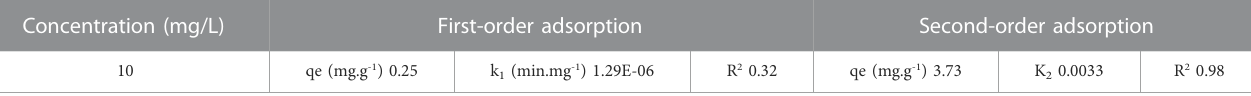
TABLE 4 Summary of kinetic studies for MB blue using 0.05 g CaO per 20 ml MB. Concentration